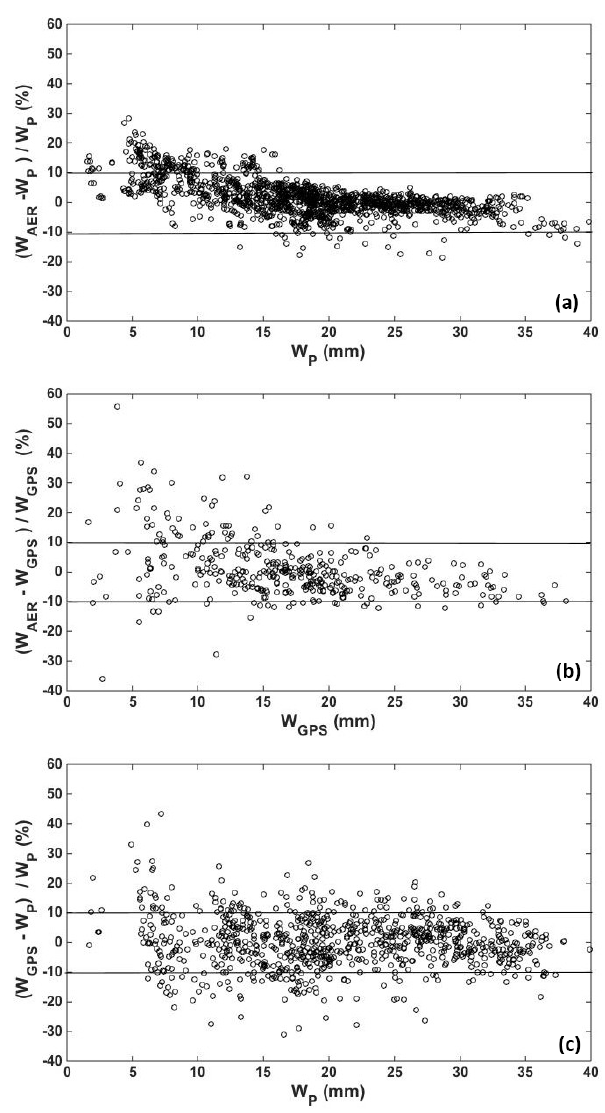
Figure 7. Percentage relative differences between W AER and W P (a) , W AER and W GPS (b) , and W GPS and W P (c) for Valencia